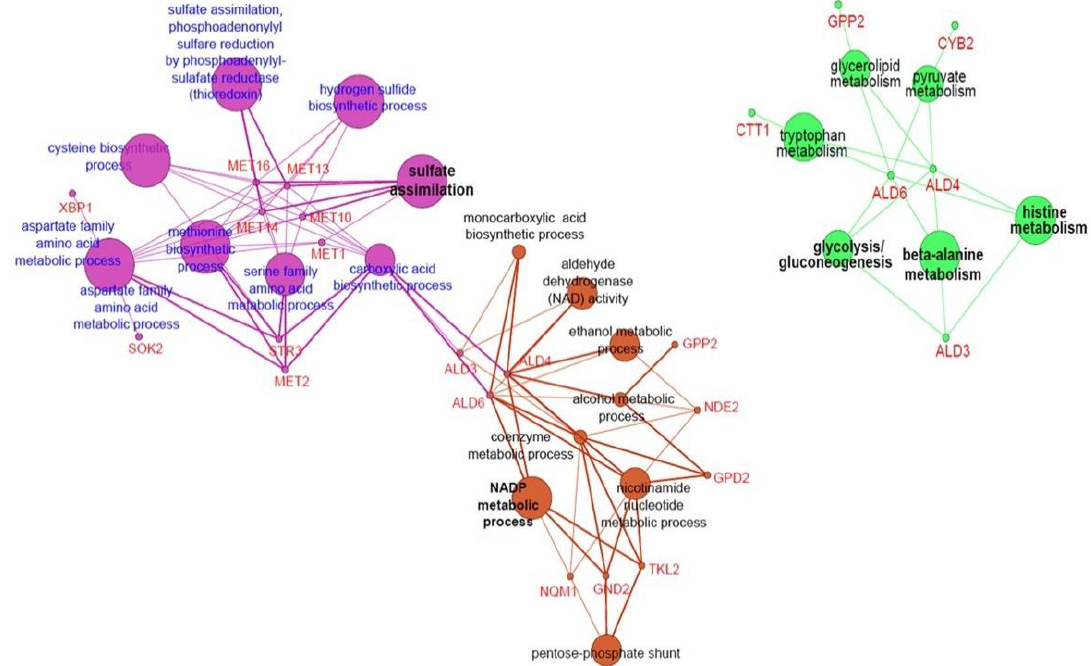
Figure 4. ClueGO-based genetic network analysis of upregulated genes involved in sulfate assimilation, NADP metabolic process, and β-alanine metabolism in DaMDHAR -expressing yeast cells under repeated FT (FT2) stress.